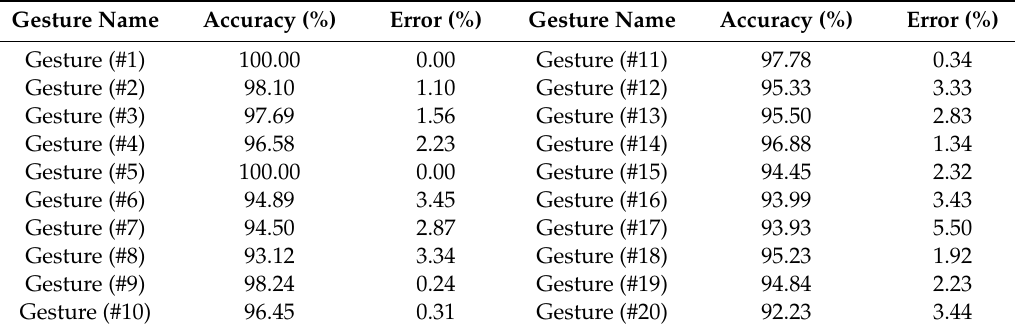
Table 2. Recognition rate according to the gesture type.